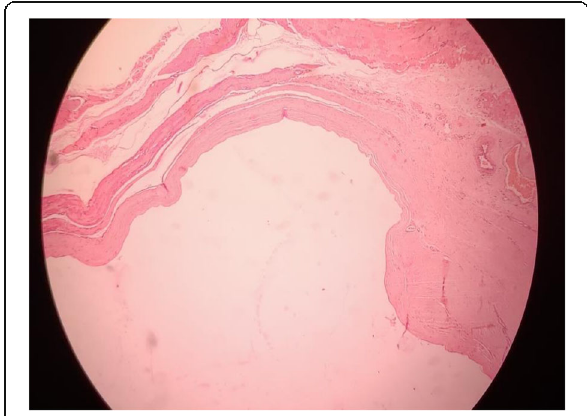
Fig. 6 Histopathology image showing multiple irregularly dilated lymphatic channels